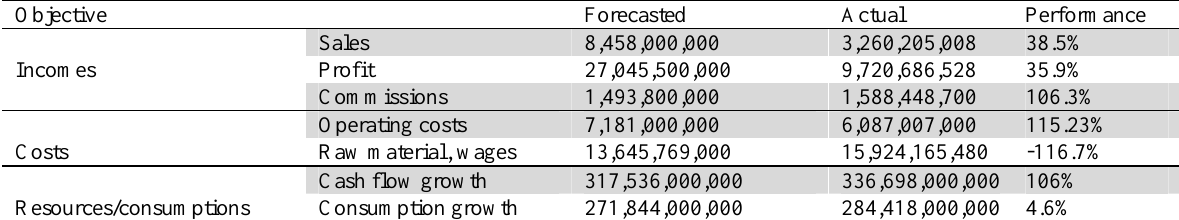
The results of forecasted and actual numbers for financial figures (Data are in Rials)